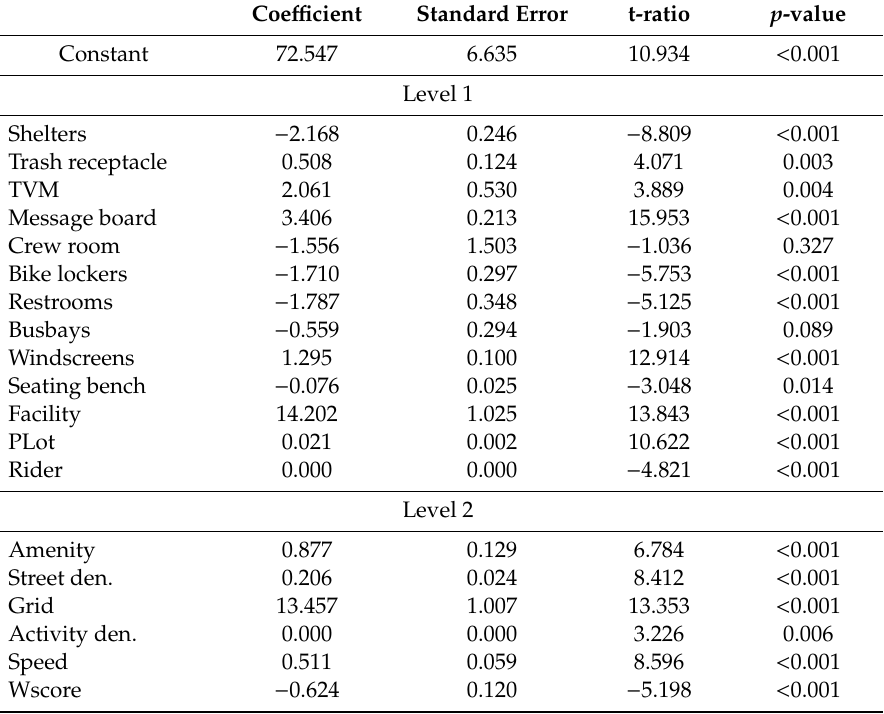
Table 6. Hierarchical linear modeling of log odds of sound levels in TOD